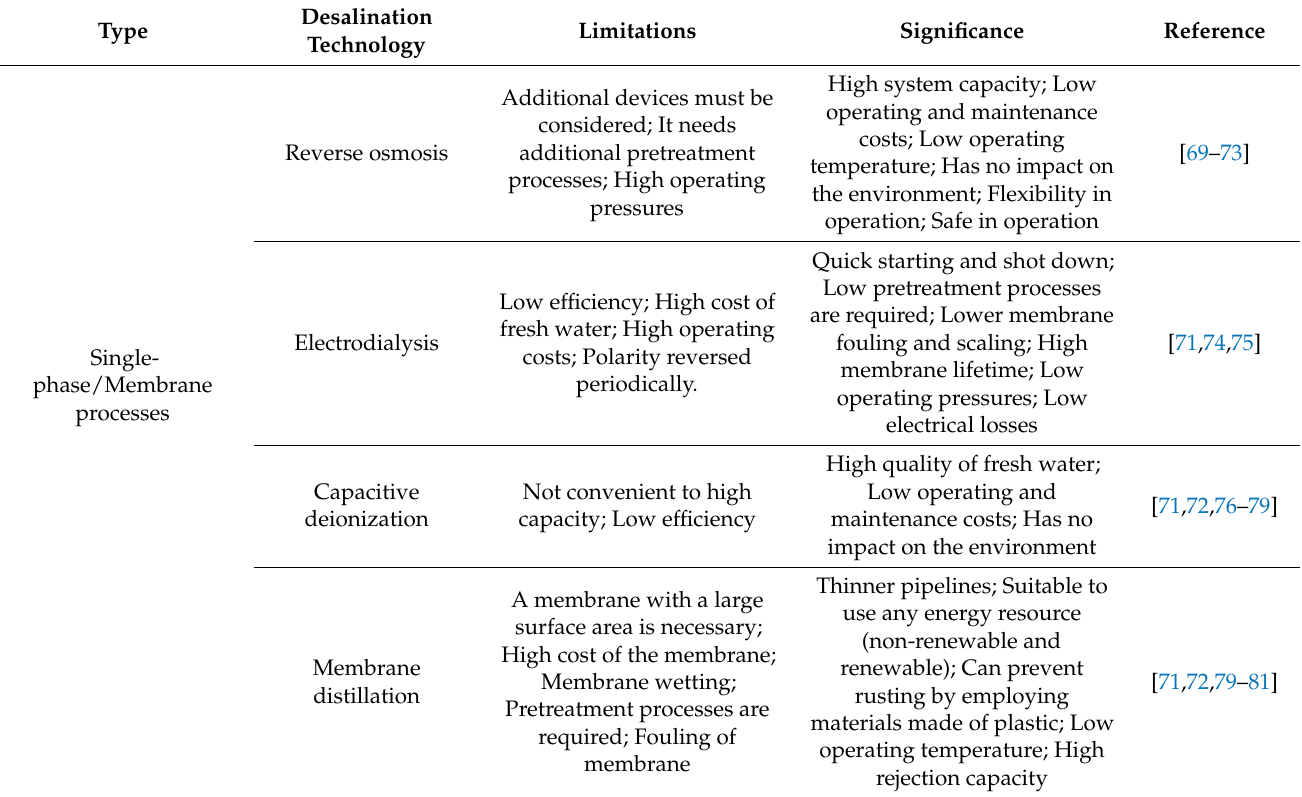
Table 1. Limitations and significance of several water desalination